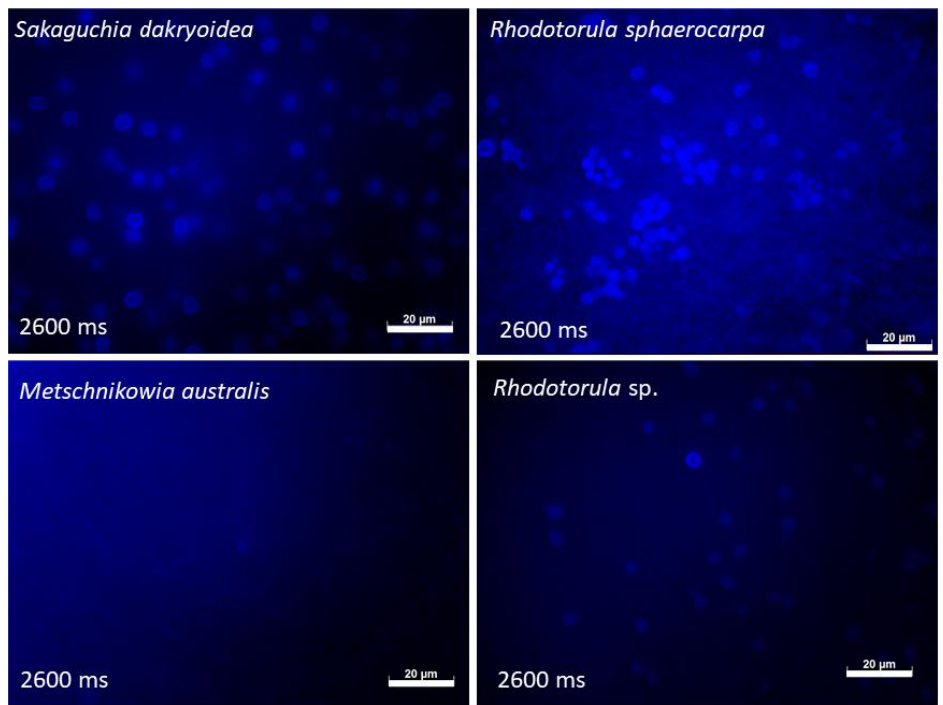
Figure 4. Autofluorescence of four marine yeasts grown in eutrophic medium and sampled in the exponential phase. All pictures were made in the DAPI channel, exposure times are depicted in milliseconds (ms). Scale bar = 20 µm.